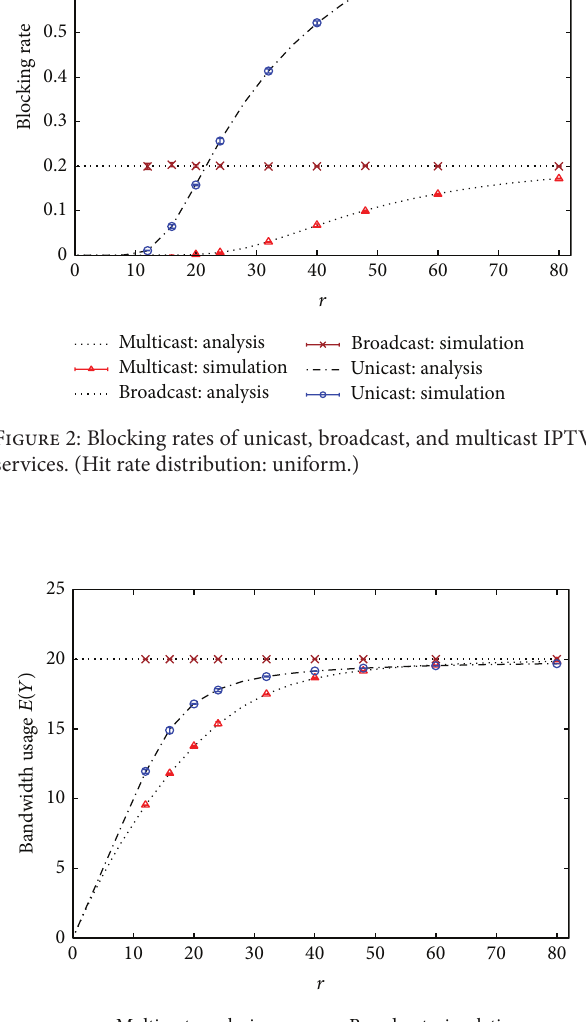
Figure 5: Bandwidth usages of unicast, broadcast, and multicast IPTV services. (Hit rate distribution: Zipf-like distribution with 𝑎 = 1